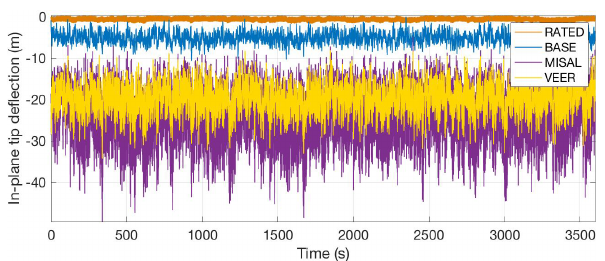
Figure 8. Time series of in-plane blade tip deflection for turbine simulations at a radial position of 12km with rated wind (RATED), baseline wind (BASE), wind with veer (VEER), and misaligned wind